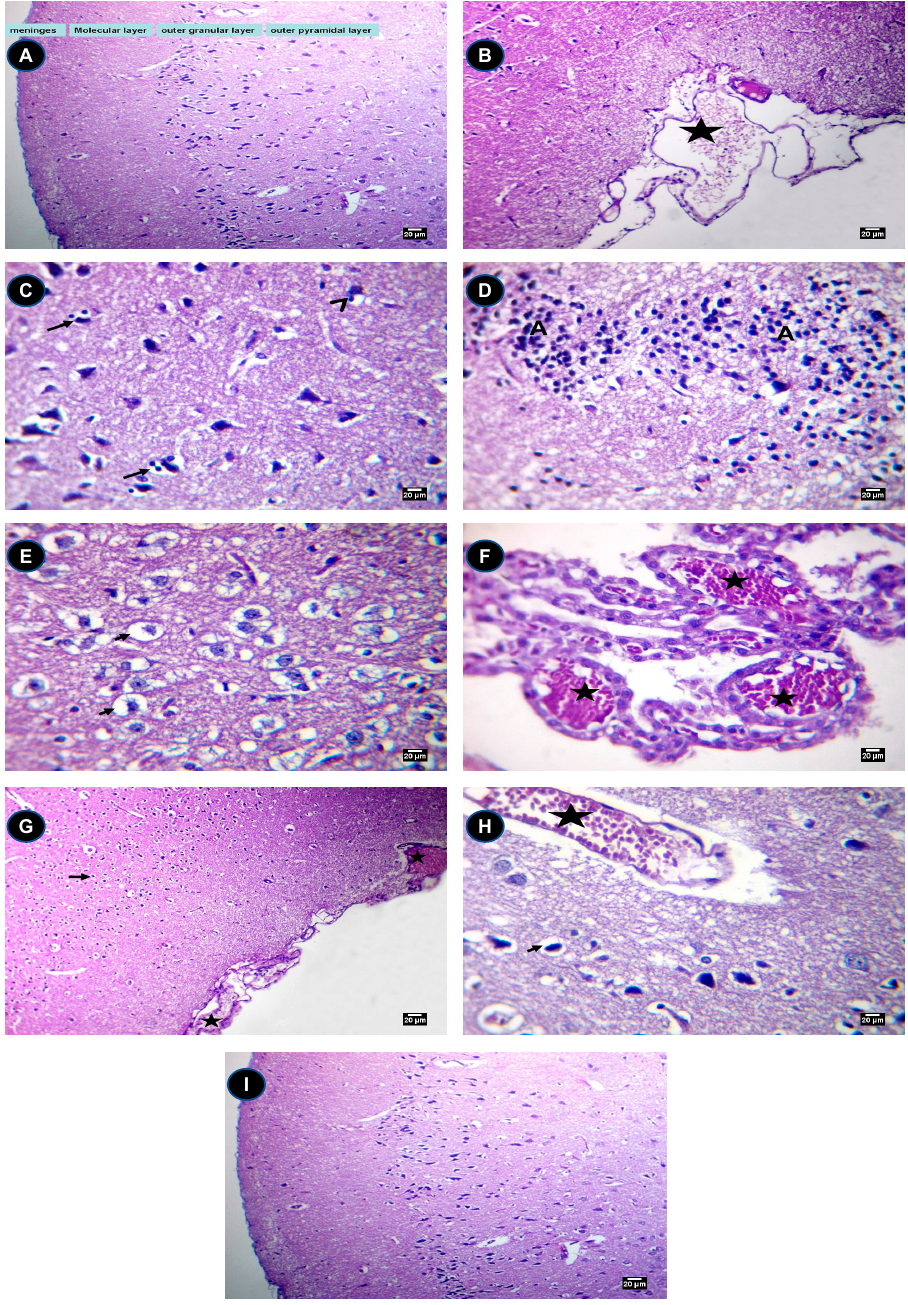
Scheme 1. Histopathology assessment. ( A ) The brain of a rat showing the normal histological structure of the meninges and cerebrum cortex, H and E ( × 200). ( B ) The meninges of a rat treated with IONPs showing the congestion of the submeningeal blood vessels (star), H and E ( × 200). ( C ) The cerebrum of a rat treated with IONPs showing satellitosis (arrows) and neuronophagia (arrowhead), H and E ( × 400). ( D ) The cerebrum of a rat treated with IONPs showing gliosis ( A ), H and E ( × 400). ( E ) The cerebrum of a rat treated with IONPs showing spongiosis (short arrows), H and E ( × 400). ( F ) The choroid plexus of a rat treated with IONPs showing severe congestion (stars), H and E ( × 400). ( G ) The brain of a rat in the IONPs + Q25 group showing spongiosis (short arrows) and the congestion of the submeningeal blood vessels (stars), H and E ( × 200). ( H ) The cerebrum of a rat in the IONPs + Q50 group showing mild spongiosis (short arrows) and the congestion of blood vessels (star), H and E ( × 400). ( I ) The brain of a rat in the IONPs + Q100 group showing a relatively normal histological structure of the meninges and cerebrum cortex, H and E ( × 200). Scale bar = 20 µ